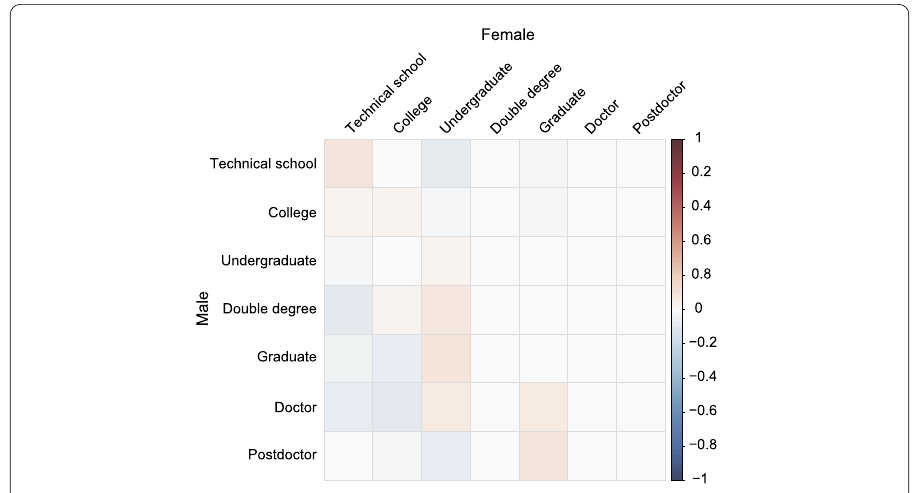
Figure 5 Education level preference for male users sending messages to female users. The vertical axis indicates the male education levels and the horizontal axis indicates the female education levels. Preference values are represented by different colors